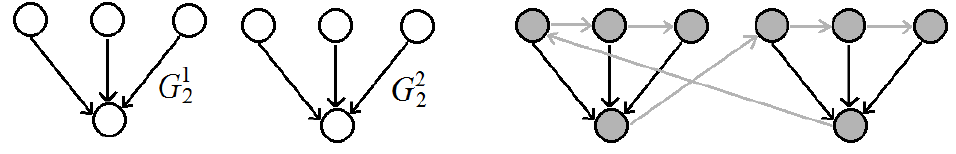
Figure 3. A strongly connected digraph constructed from the stars G 1